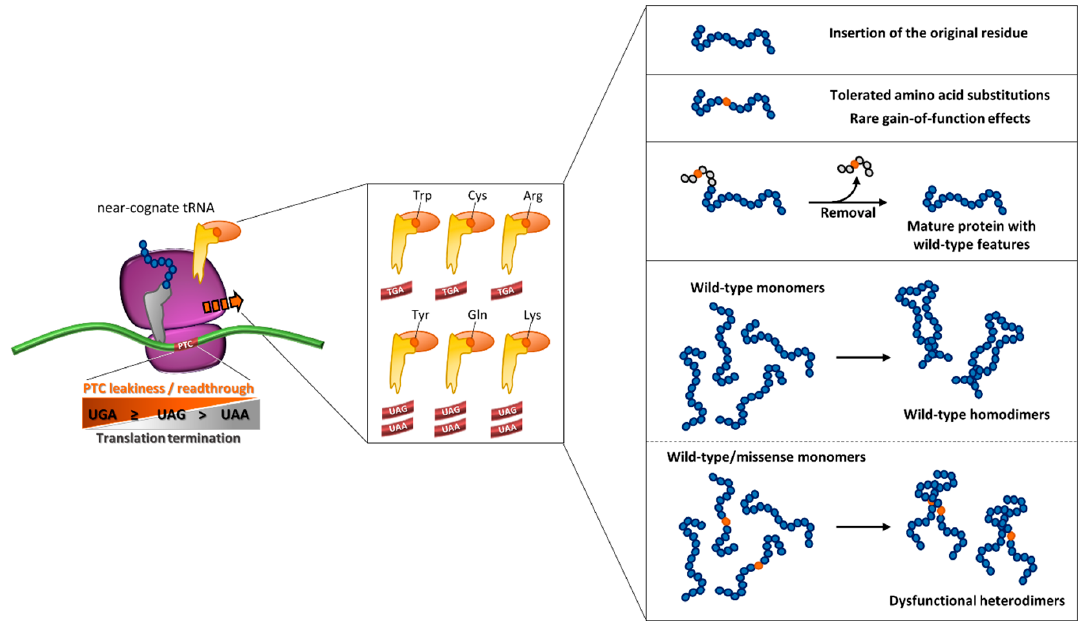
Figure 5. Outcome of readthrough as an integrated interplay of molecular determinants. The degree of readthrough of translating ribosome is driven by PTC type, which leads to the differential insertion of a subset of amino acids brought by near-cognate aa-tRNAs. A scenario of the resulting readthrough-mediated protein output is depicted in the right panels (see text for details).